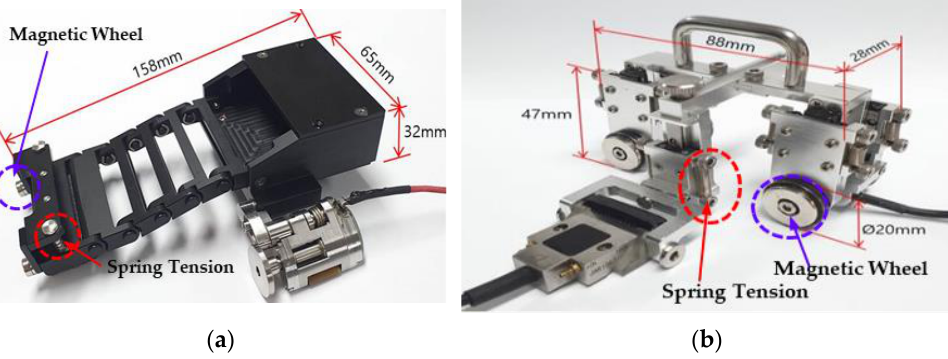
Figure 15. Schematic diagram of scanners designed to be driven on pipe curvature: ( a ) low-profile scanner with flexible PA probe; ( b ) encoded XY scanner for wedge. scanner with flexible PA probe; ( b ) encoded XY scanner for wedge.